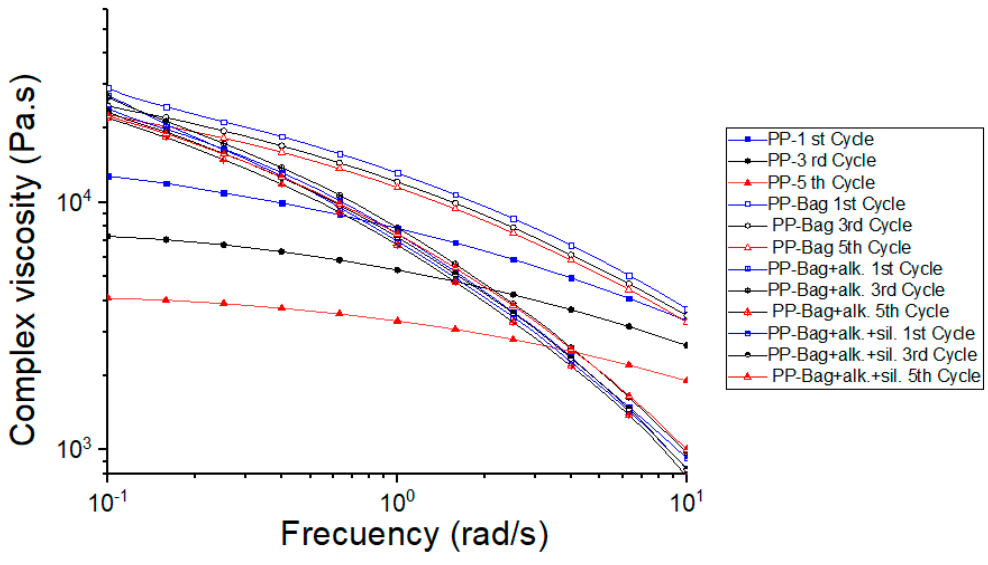
Figure 11. Complex viscosity as a frequency function of PP and PP-Bagasse biocomposites.